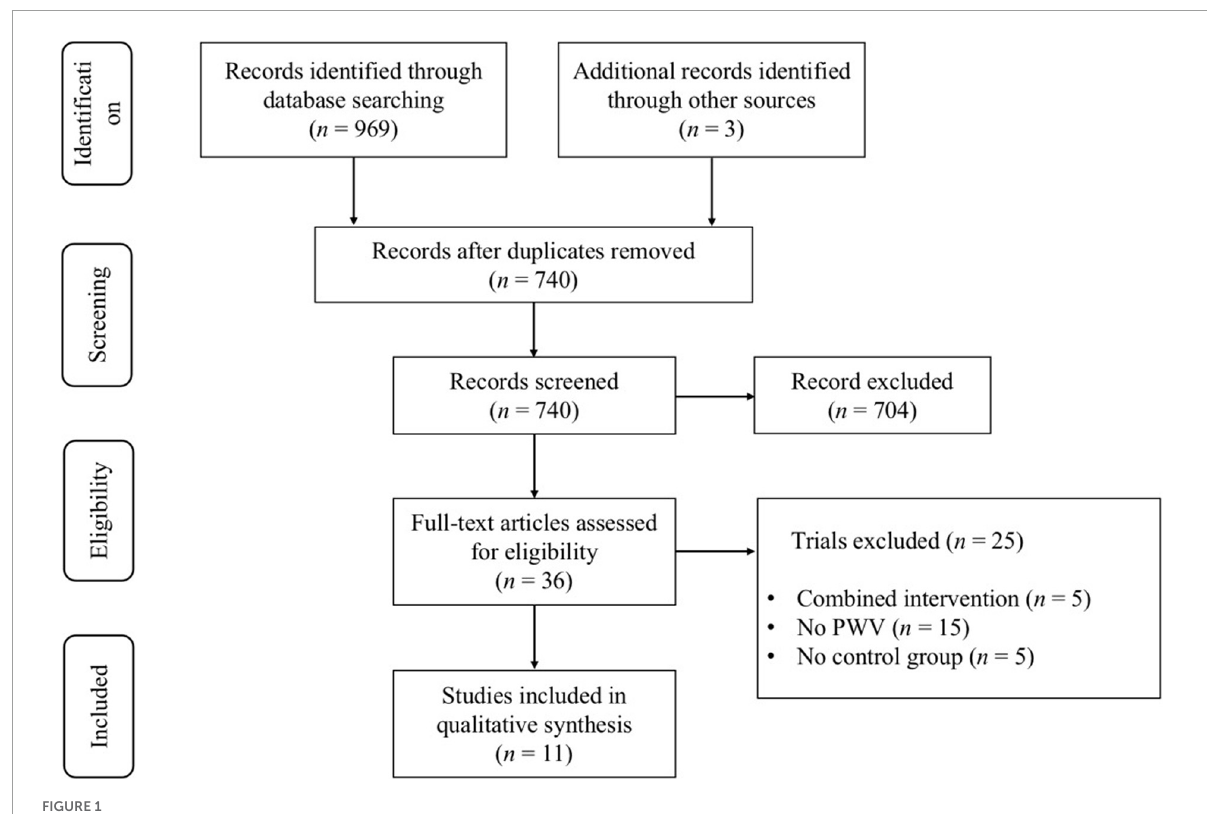
FIGURE1 PRISMA flowchart of study